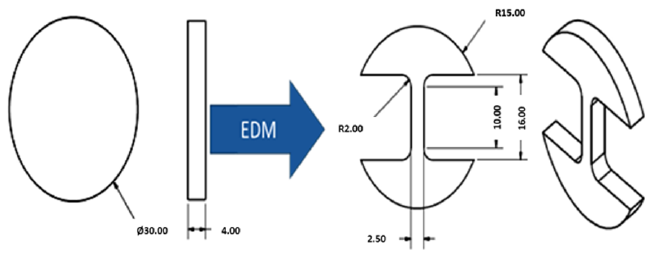
Figure 2. Schematic diagram of tensile test sample produced by EDM.